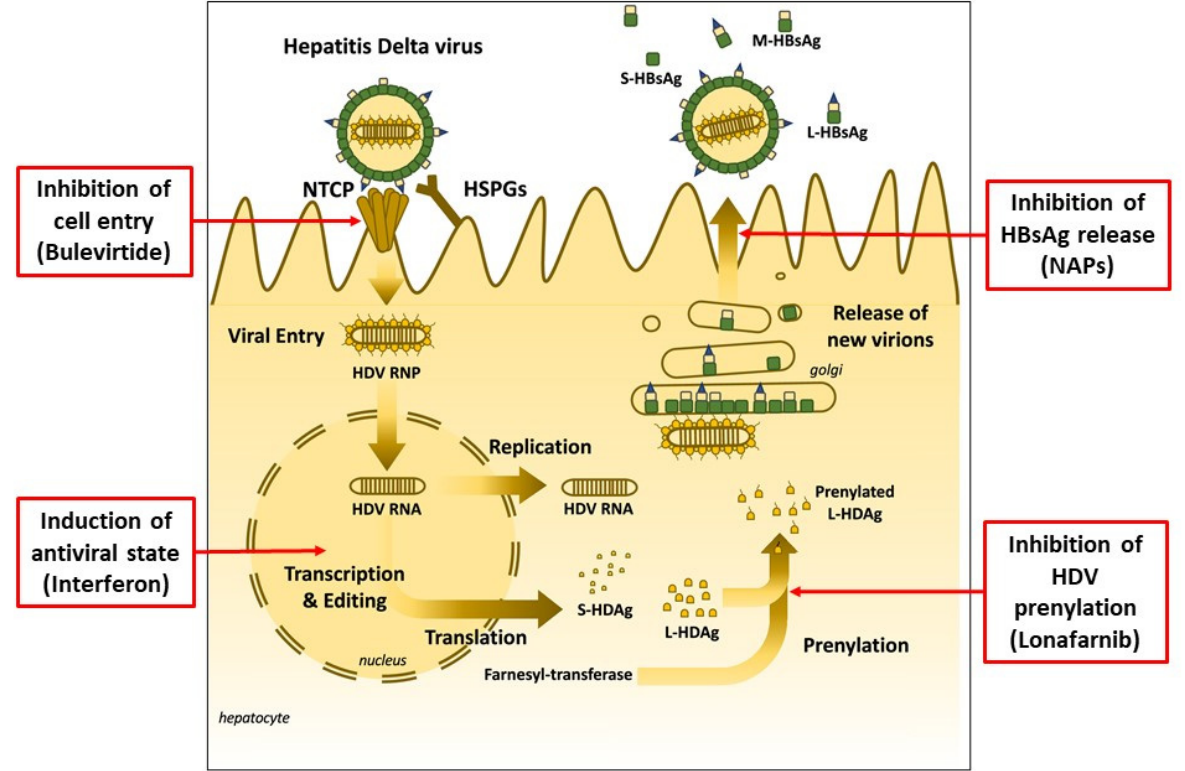
Figure 1. Hepatitis Delta Virus infection and therapeutic targets of currently available and experi- mental new drugs (adapted from Liver Int. 2021 , 41 (Suppl. 1), 30–37, used with